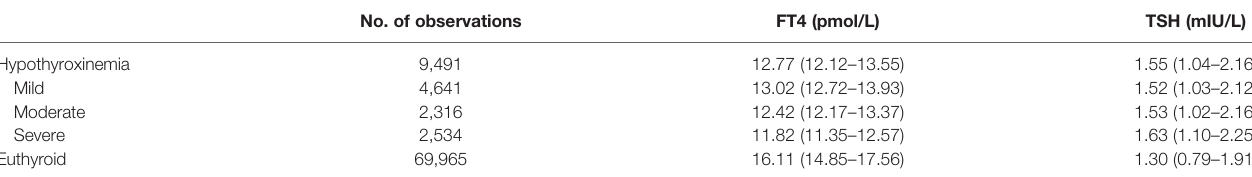
TABLE 2 | Description of FT4 and TSH levels (medians, interquartile